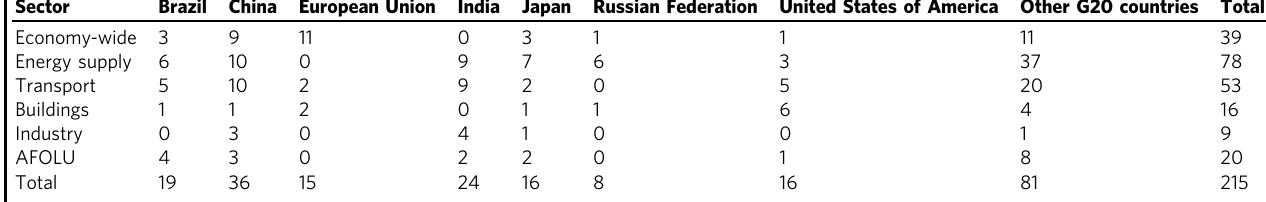
Table 5 Number of high-impact policies selected for implementation in the IAM models, per sector and country (details in, Supplementary Table